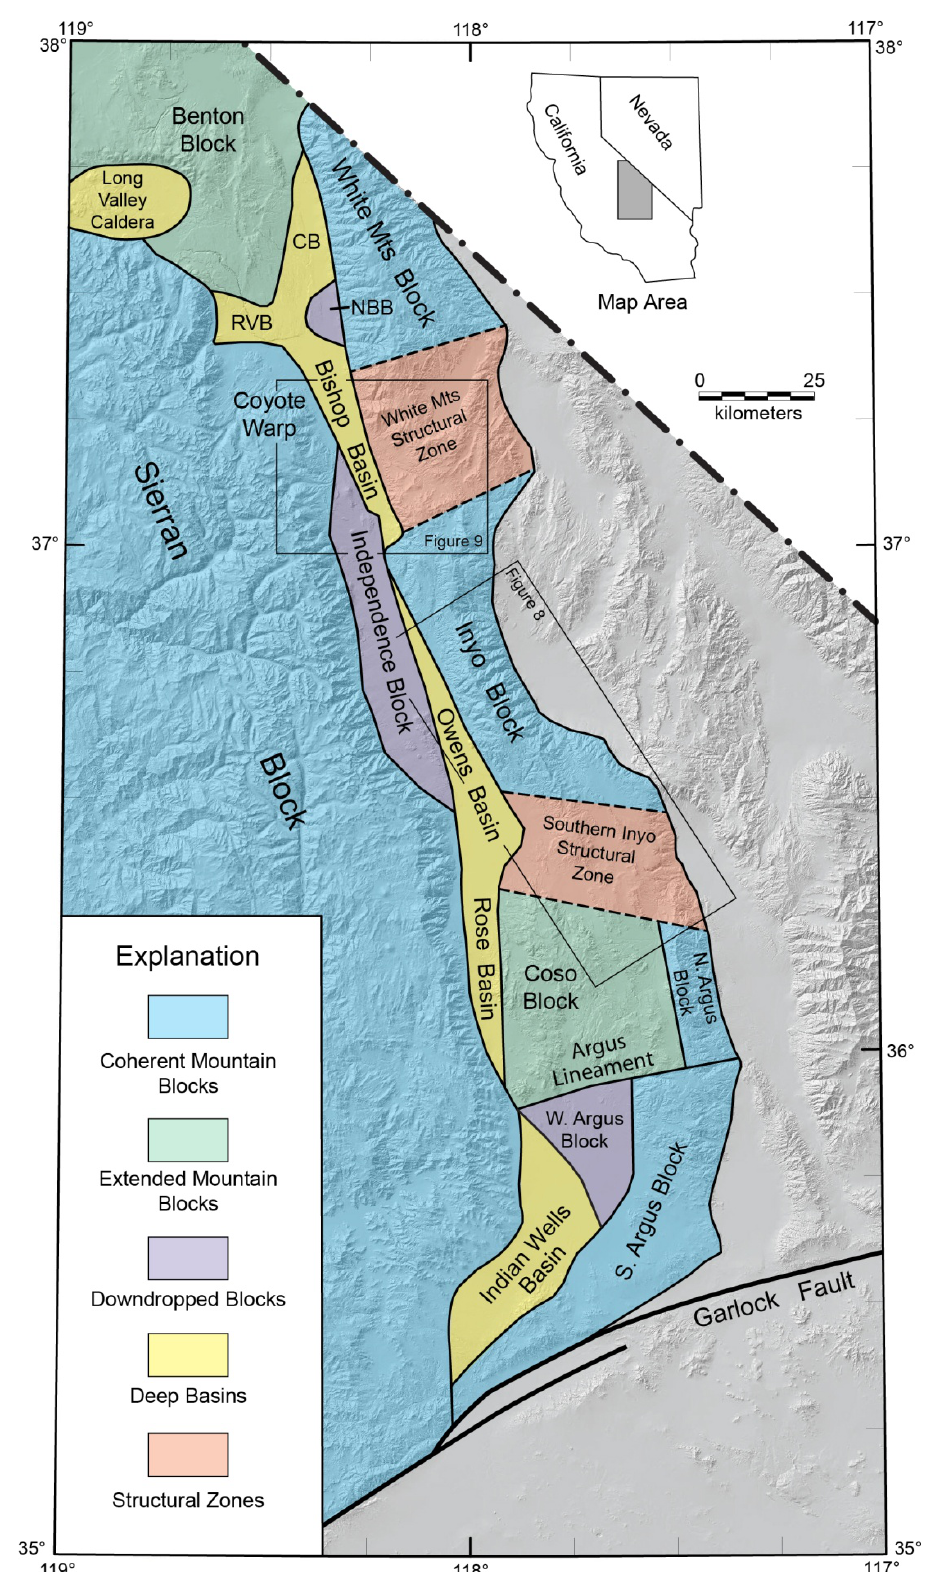
Figure 7. Map showing deep basins, relatively shallow down-dropped blocks, extended mountain blocks, and structural zones in the ESVS, which is bounded by largely unextended mountain blocks. CB = Chalfant Basin; NBB = North Bishop Block; RVB = Round Valley